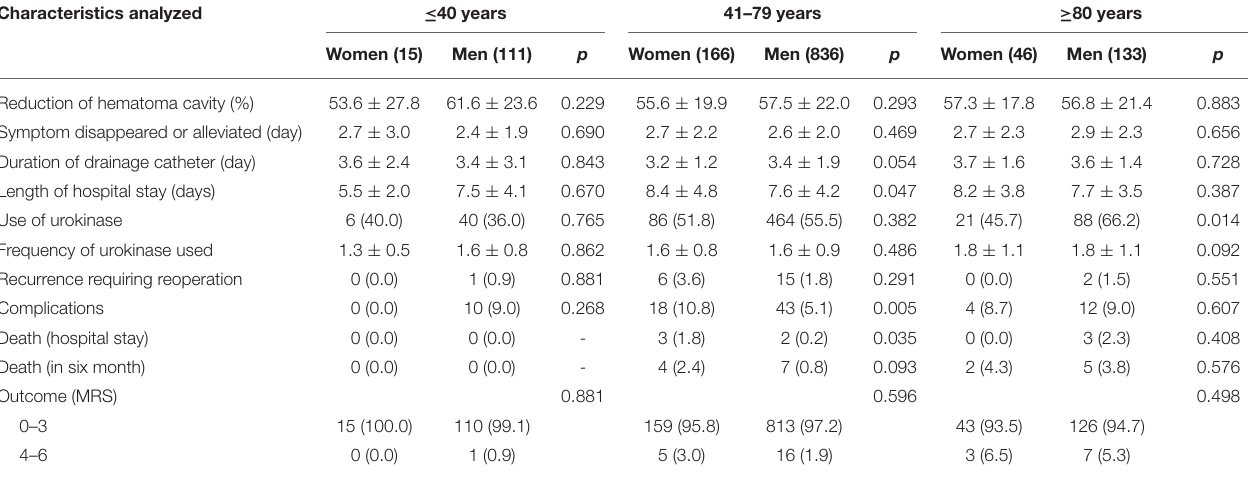
TABLE 5 | Relationship between clinical characteristics and groups of gender in different age patients with chronic subdural hematoma after surgery. Characteristics